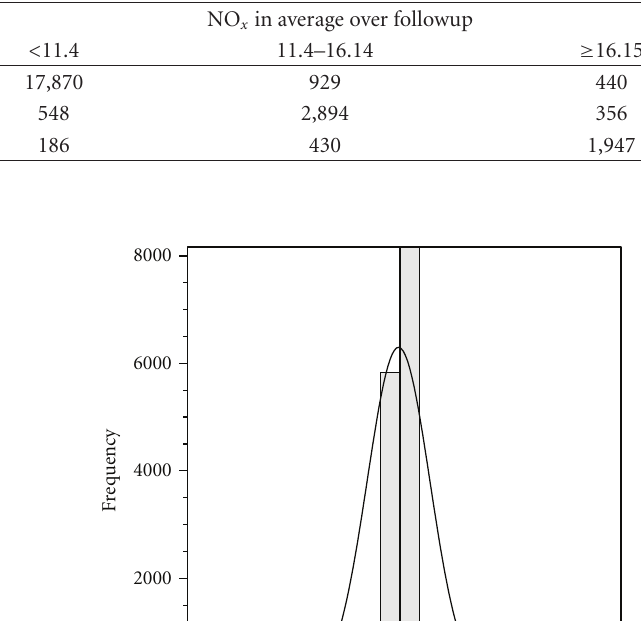
Table 3: Cross-tabulation between NO x categorized into < 75th percentile, 75th to 90th percentile, and ≥ 90th percentile ( μ g/m 3 ).